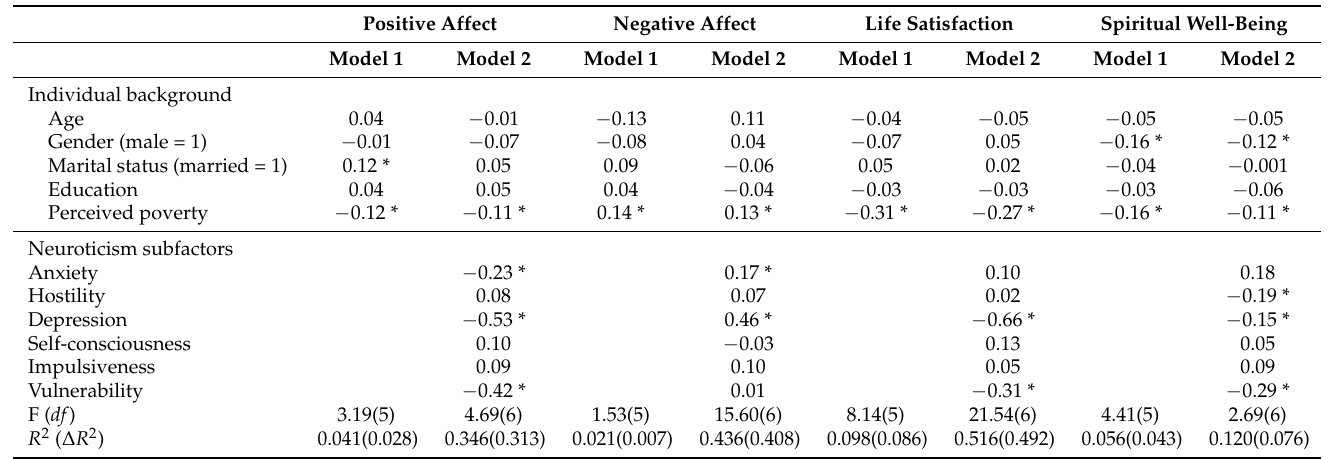
Table 3. Hierarchical regression analysis predicting subjective and spiritual well-being